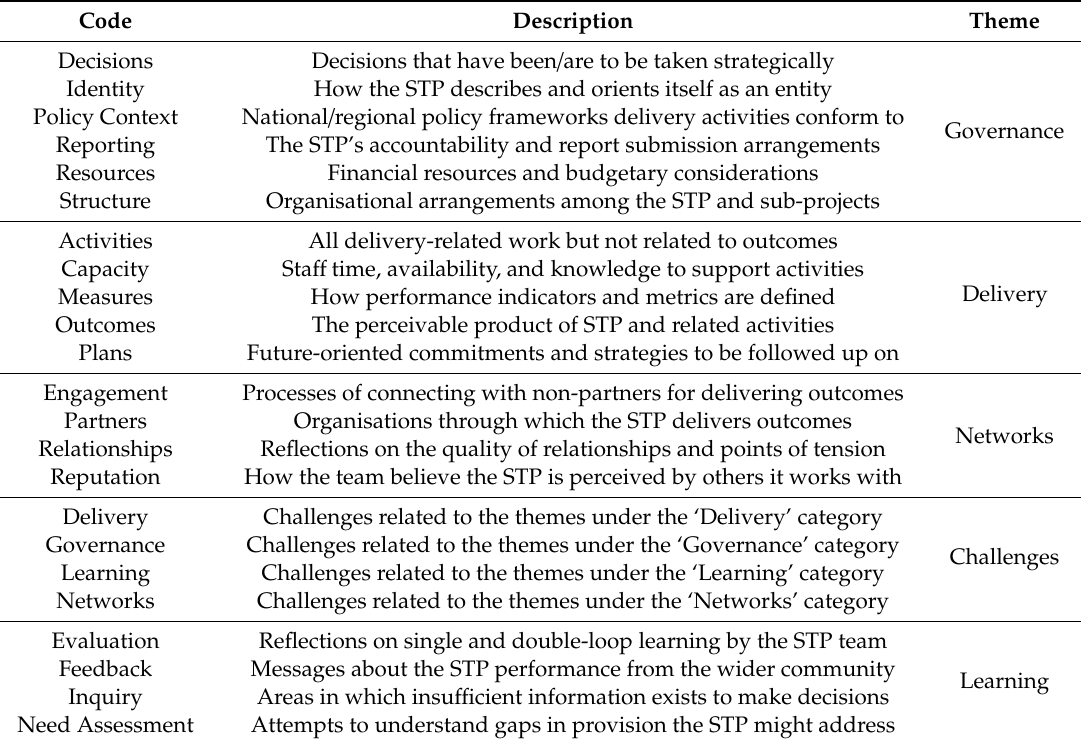
Table 6. Summary of thematic